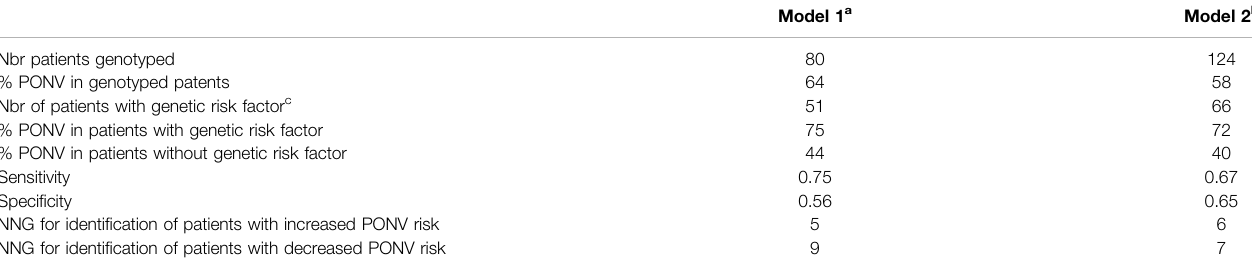
TABLE 6 | Prediction model parameters.